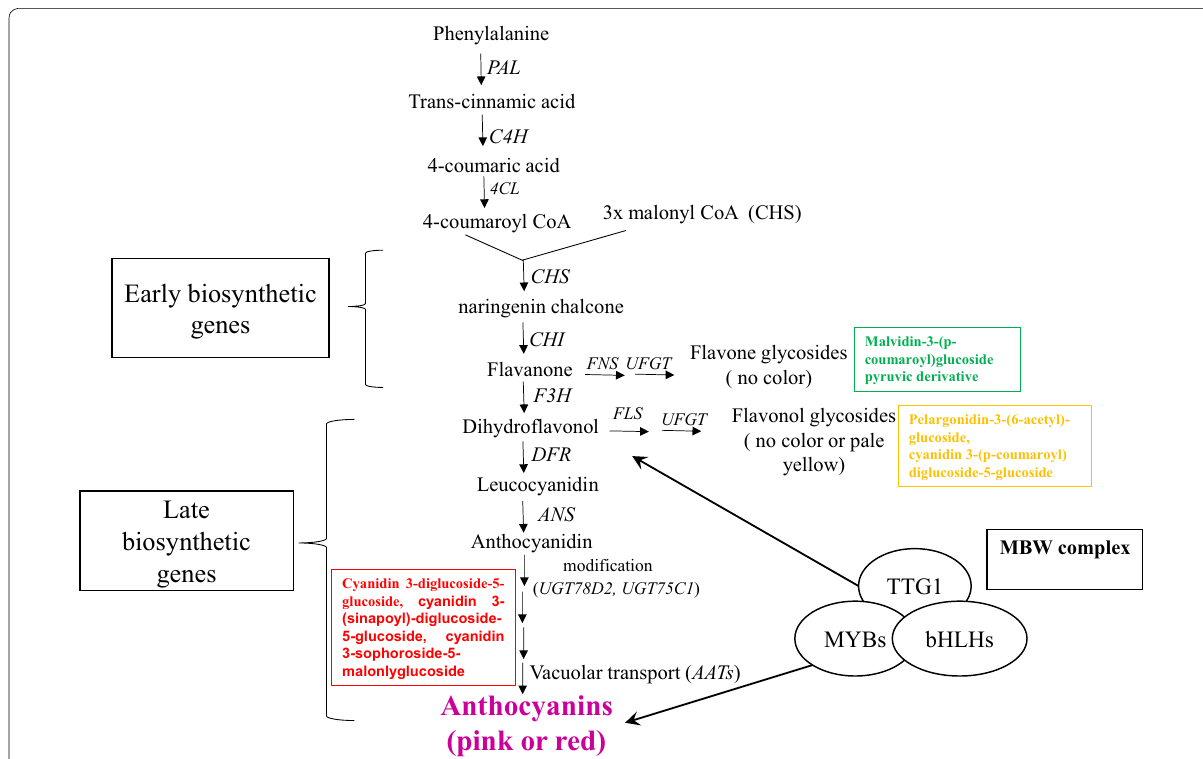
Fig. 1 Schematic and simplified diagram of the anthocyanin biosynthesis pathway leading to the accumulation of anthocyanin in Brassica . The pathway is divided into three major parts; the upstream phenylpropanoid pathway, the early biosynthetic pathway, and the late biosynthetic pathway, based on the types of genes involved in each stage. The possible activation sites of the regulatory MBW complexes are indicated. Details of the genes involved in each stage are provided in Table 2. PAL phenylalanine ammonia lyase, C4H cinnamate‑4‑hydroxylase, 4CL 4‑coumaratel‑CoA ligase, CHS chalcone synthase, CHI chalcone isomerase, F3H flavanone‑3‑hydroxylase, FLS flavonol synthase, DFR dihydroflavanol reductase, ANS anthocyanidin synthase, UGT uradin glycosyltransferase, MYB myeloblastosis family of transcription factors, bHLH basic